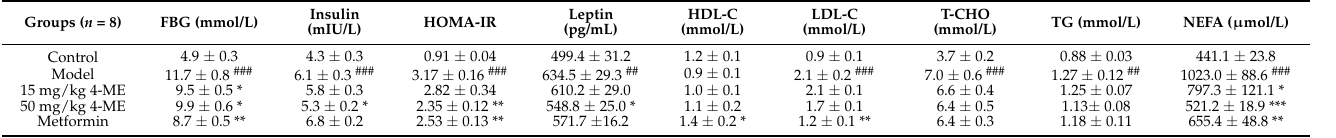
Table 2. Effects of 4-ME on serum biochemical parameters in HFD-fed